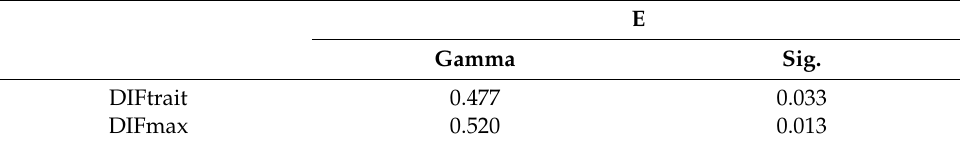
Table 3. Gamma coefficients and statistical significance between the Ermakov–Lewis energy (E) and the DIFtrait and DIFmax variables.